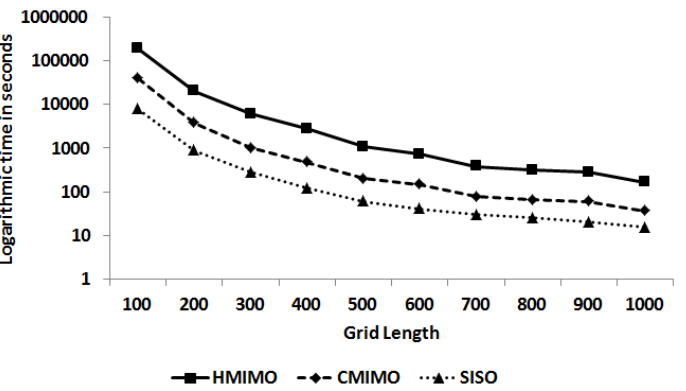
Figure 6. Comparison of network lifetime.